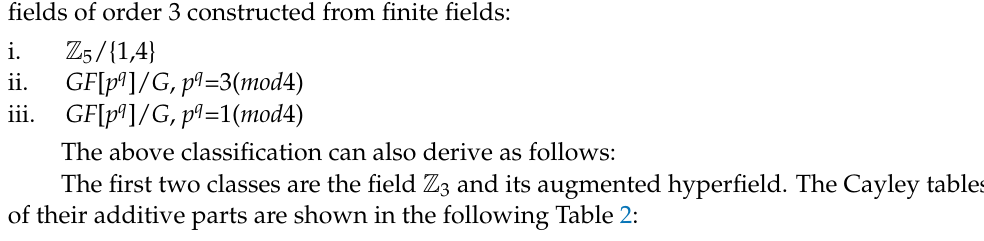
Table 2. The Cayley tables of the additive group of ℤ 3 and of the additive canonical hypergroup of its augmented hyperfield [ ℤ 3 ] .